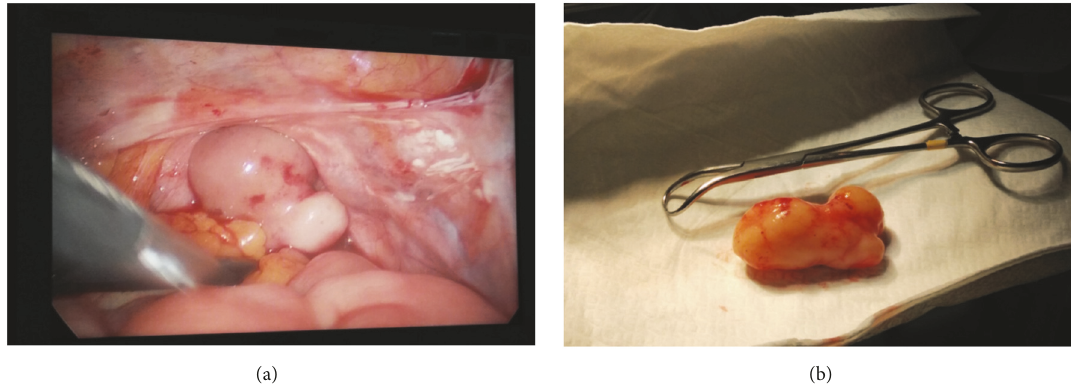
Figure 3: (a) Laparoscopic appearance of the vaginal vault. (b) Macroscopic aspect of the excised mass.